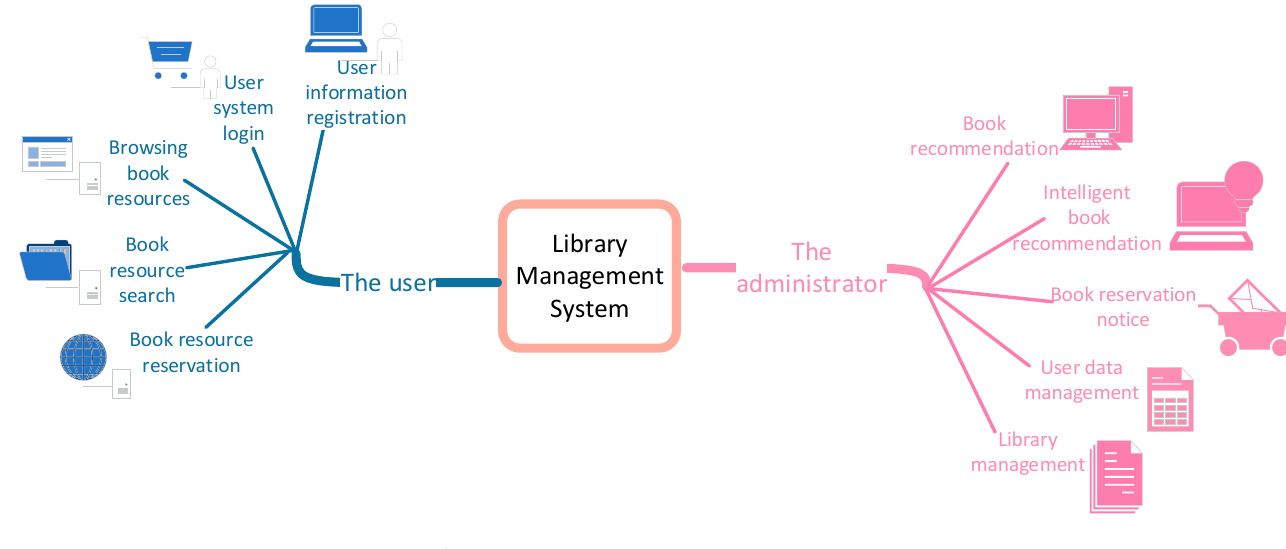
Figure 4. Library management system structure.